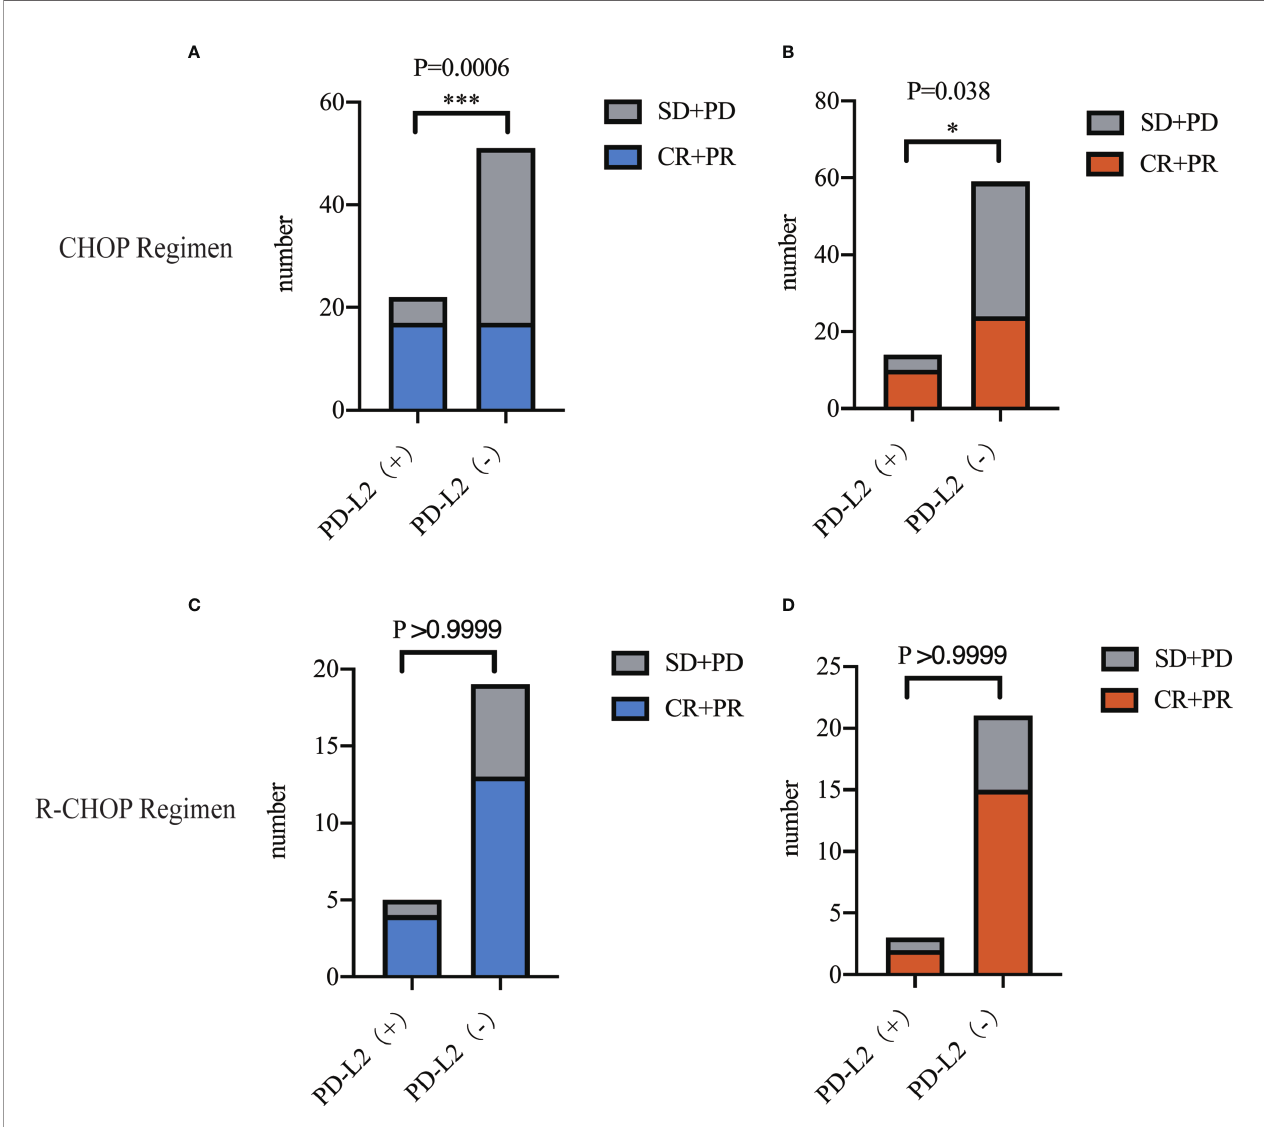
FIGURE 3 | Objective response rates of TC (A) /IC (B) PD-L2 (+) and PD-L2 ( − ) patients receiving CHOP regimen. Objective response rates of TC (C) /IC (D) PD-L2 (+) and PD-L2 (-) patients receiving R-CHOP